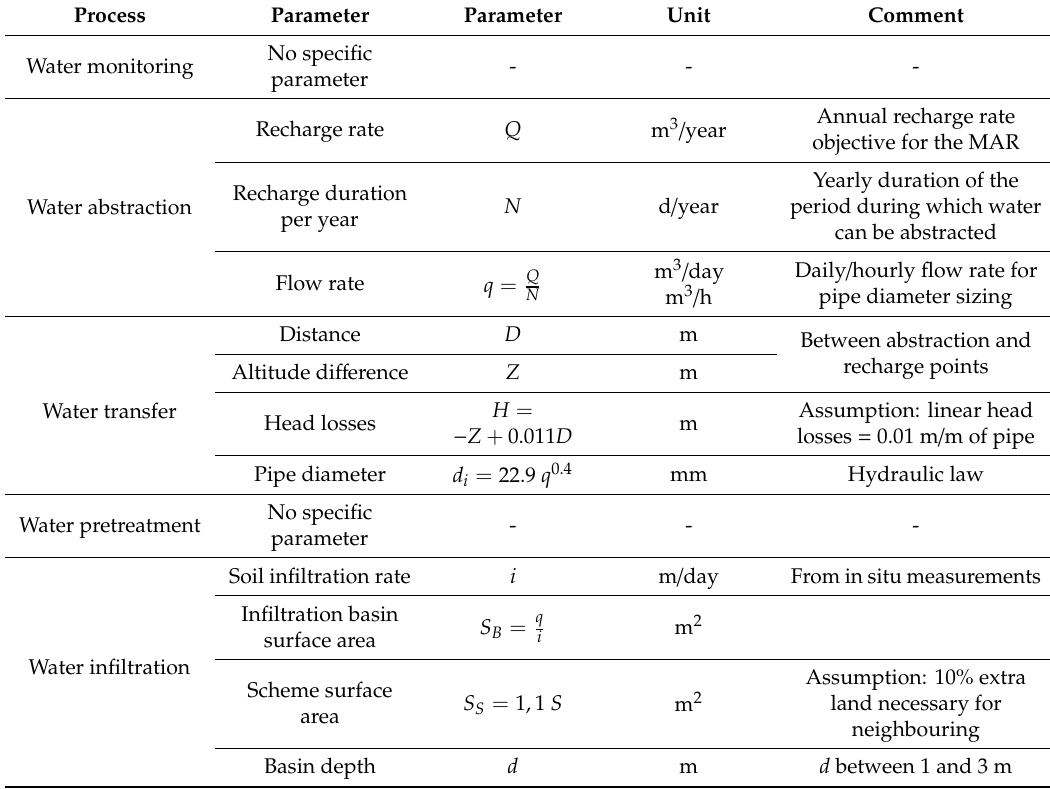
Table 1. Main parameters of an MAR scheme with infiltration basin project